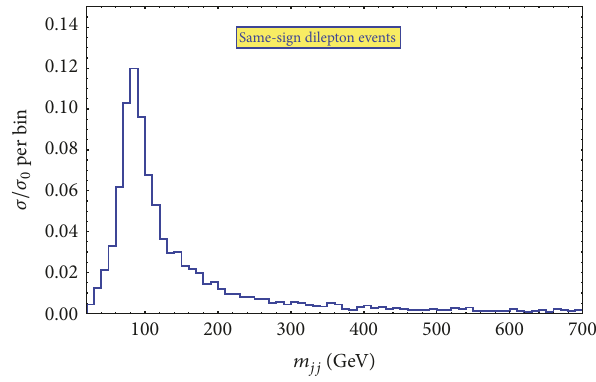
Figure 13: Transverse momenta distributions for the three leptons from the 3 ℓ + MET final state from pp → 𝑁ℓ𝑋 , 𝑁 → ℓ𝑊 , 𝑊 → ℓ ] at the 13TeV LHC.